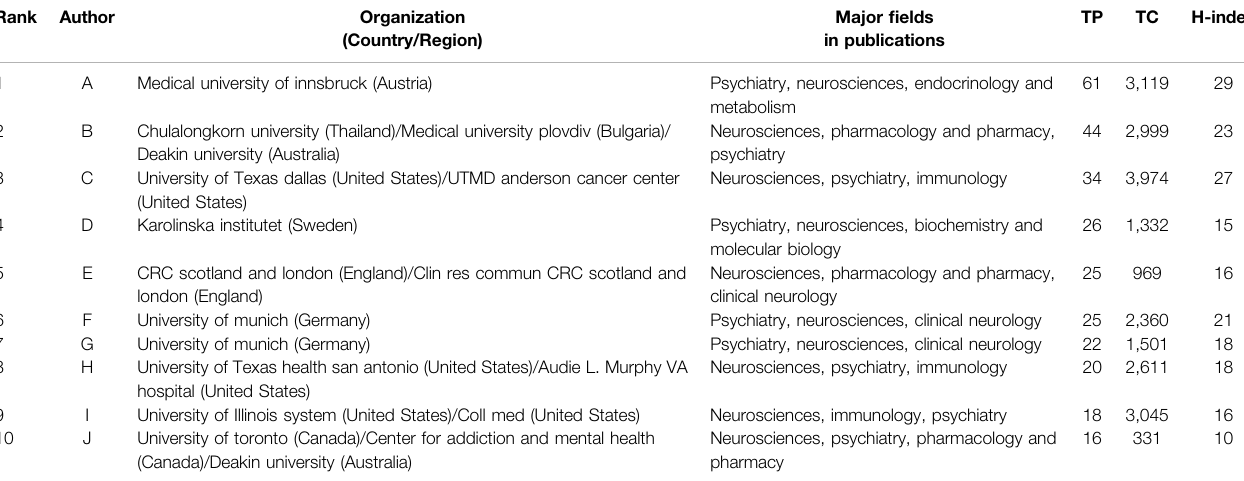
TABLE 2 | The top ten most proli fi c authors in the fi eld of the kynurenine pathway (KP) in mood disorders between 2000 and 2020.